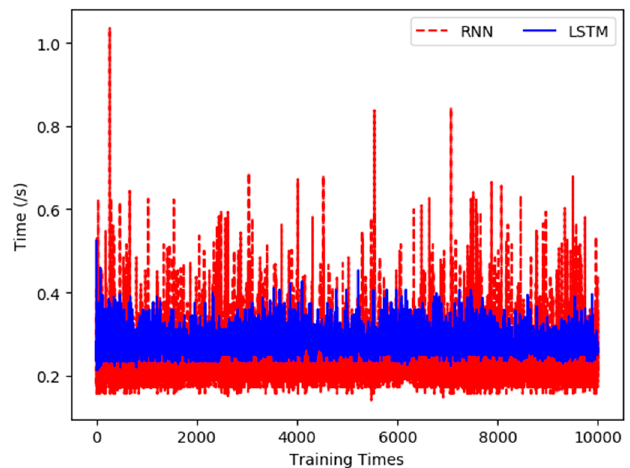
Figure 15. Comparison of training time of pH prediction model.